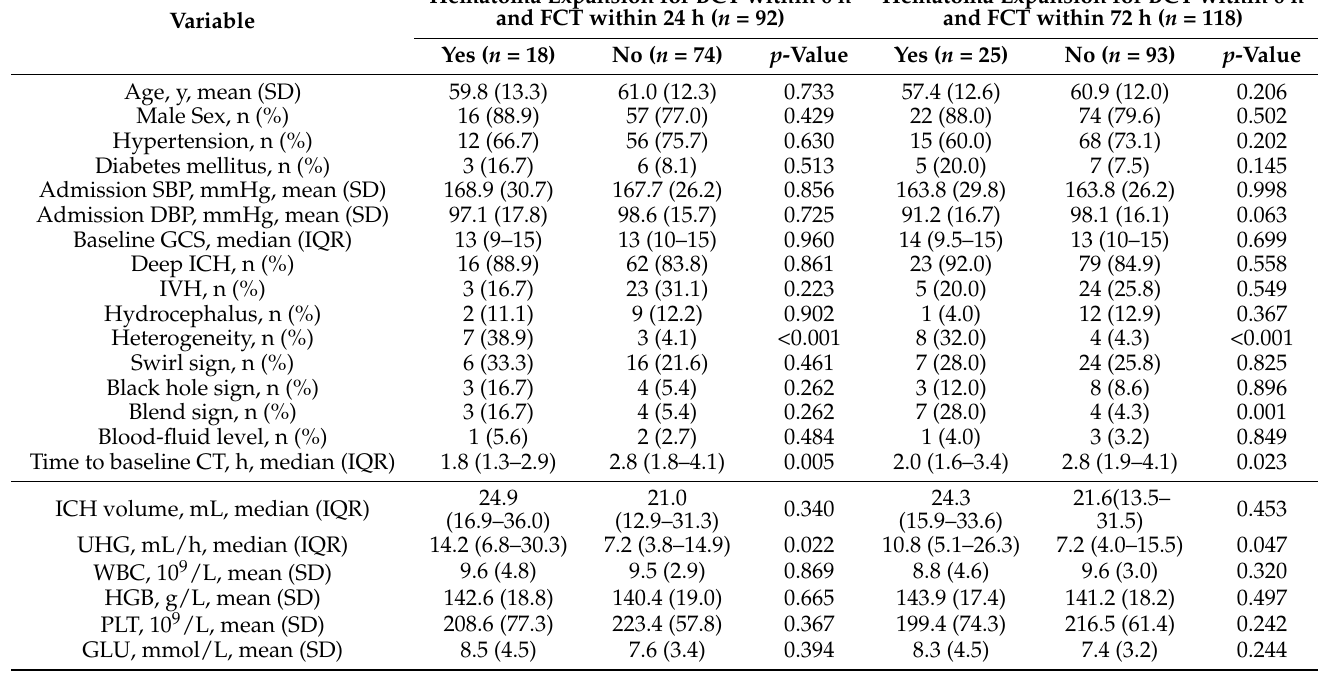
Table 2. Comparison of baseline clinical and radiological characteristics of individuals with and without hematoma expansion for the time to baseline CT within 6 h.